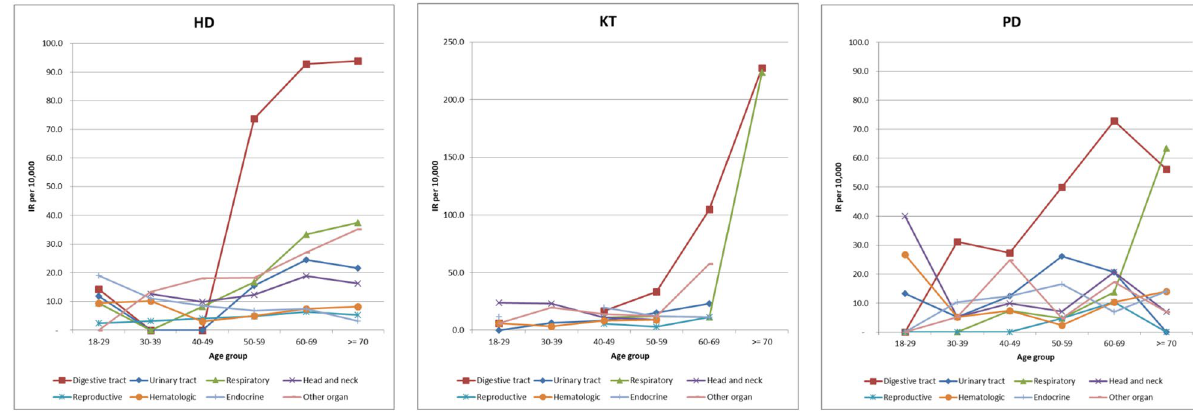
Figure 4. Incidence rates per 10,000 person-years by age group and renal replacement therapy for each cancer site. RRT, renal replacement therapy; HD, hemodialysis; PD, peritoneal dialysis; KT, kidney transplant; IR, incidence